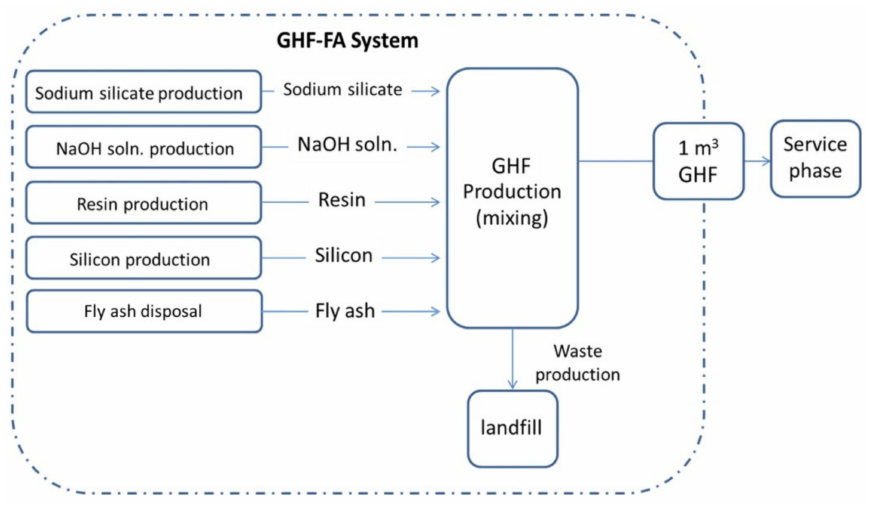
Figure 22. Description of geopolymer hybrid foams derived from fly ash (GHF-FA) life-cycle production. Reprinted from [88], © 2020 with permission from